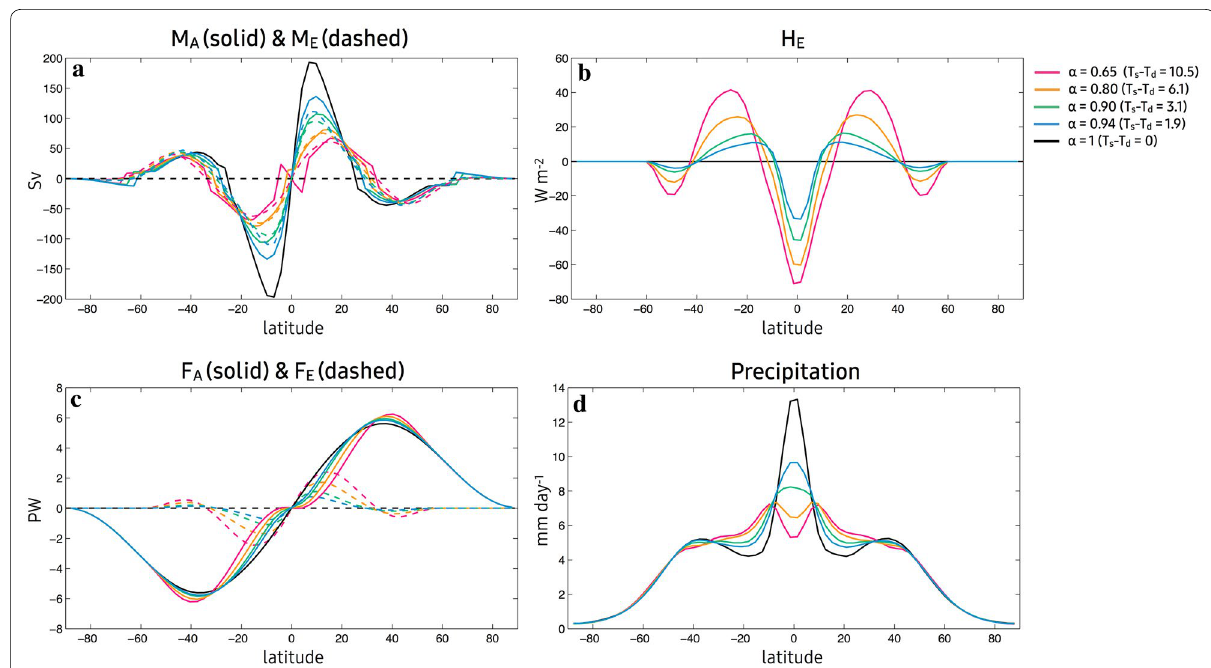
Fig. 1 The time- and zonal-mean state of CNT as a function of different T s T d , obtained by varying α . a The mass transport by the atmospheric − cells M A (solid) and by the Ekman flow M E (dashed) in Sv, b the heating induced by Ekman transport H E in W m − 2 , c the meridional energy transport by the atmosphere F A (solid) and by the Ekman flow F E (dashed) in PW, and d the precipitation in mm day −